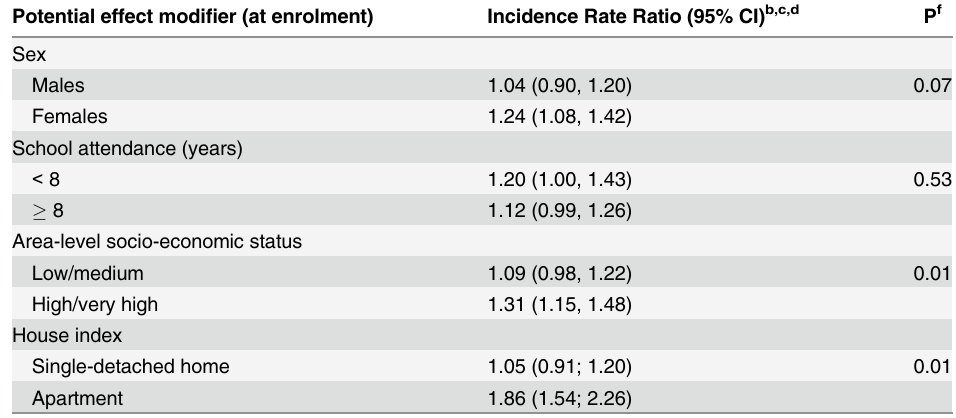
Table 3. Modifications of associations between time-weighted average residential radon exposure a (per 100 Bq/m 3 ) and basal cell carcinoma cases (n = 3243) among the 51,445 DCH cohort